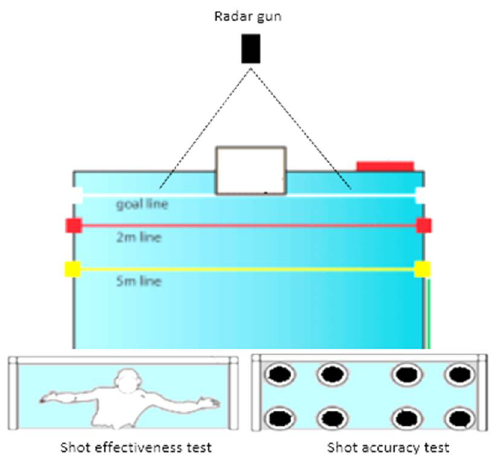
Figure 2. Shooting tests to goal and toward canvas (left and right panels, respectively).